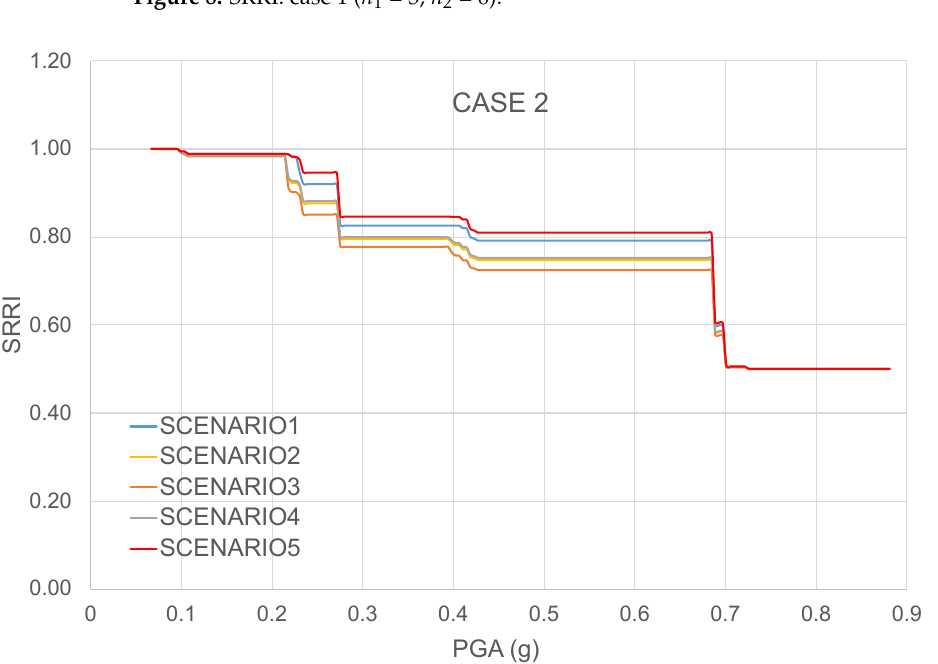
Figure 9. SRRI: case 2 ( n 1 = n 2 = 3).